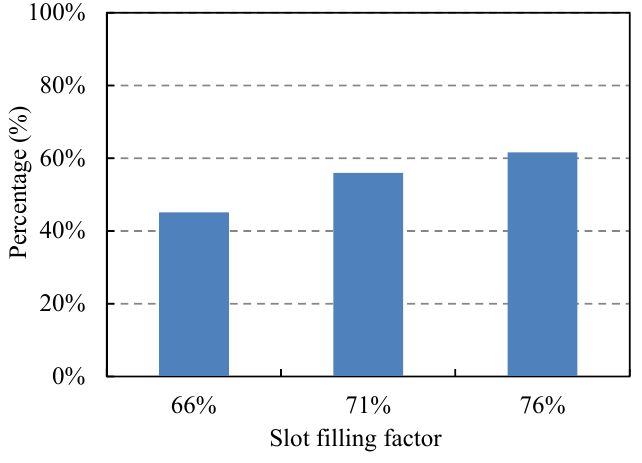
Figure 18. The proportion of winding temperature drop independently caused by increasing the wire